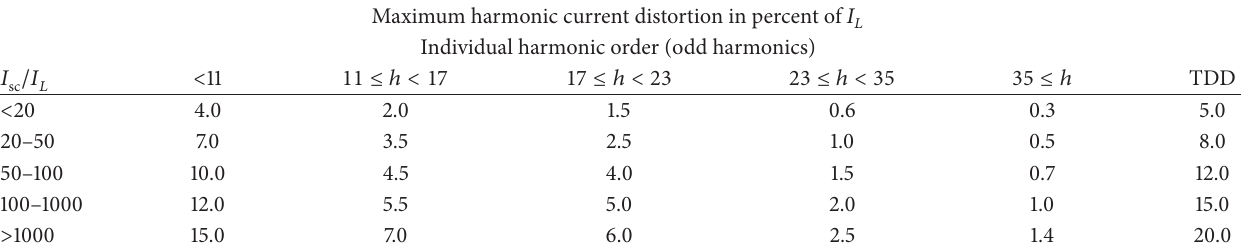
Table 2: Current distortion limits for general distribution systems (120V through 69 kV).